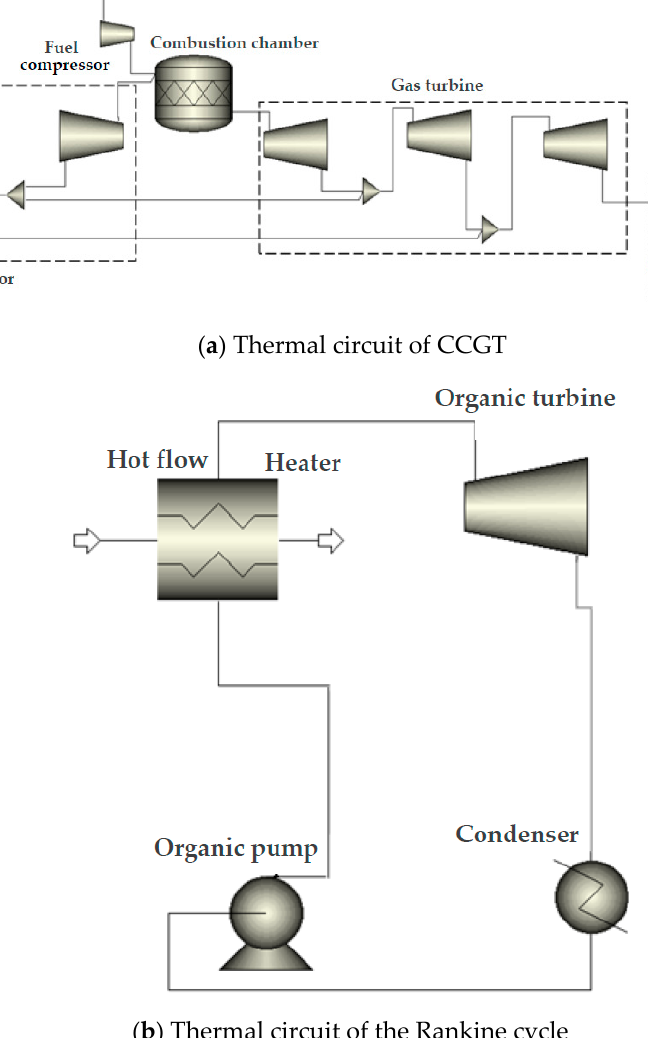
Figure 7. Mathematical models of thermal circuits.